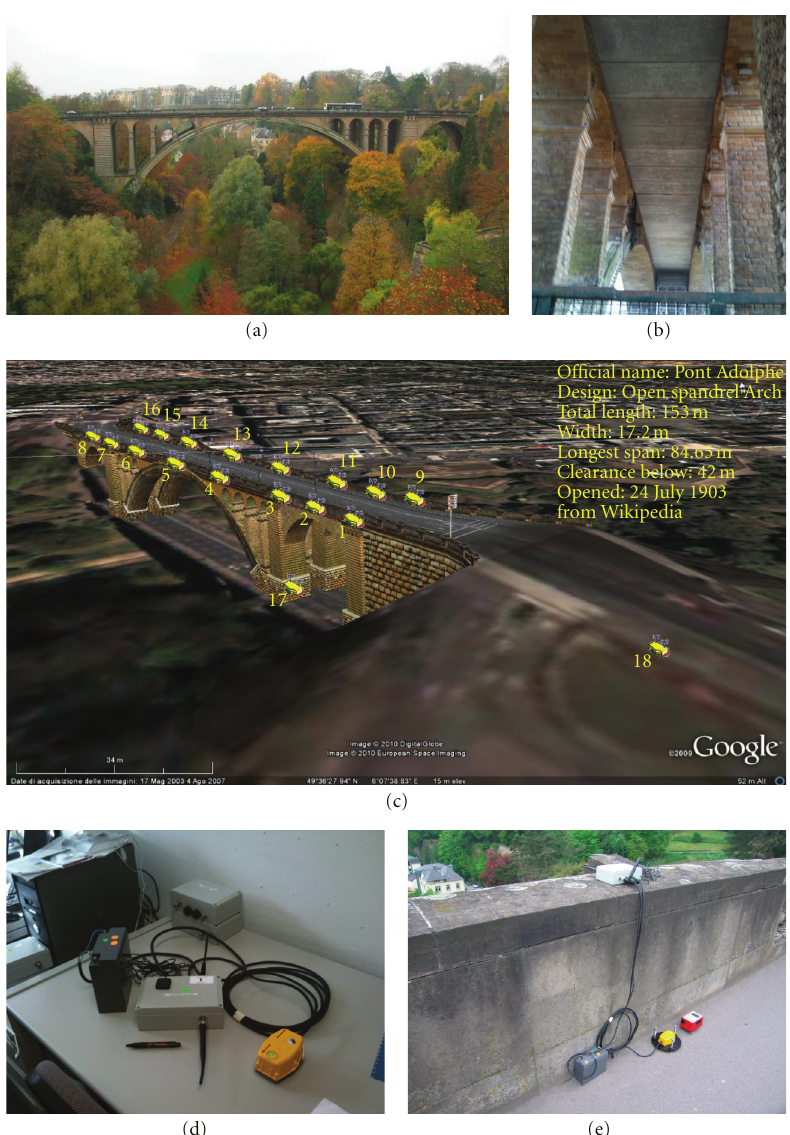
Figure 1: Photos of the Adolphe Bridge and instruments used and information on the measurement setup. (a) Sideview of the Adolphe bridge (source: Wikimedia Commons). (b) View from below. (c) Measurement setup used on the Adolphe bridge. (d) Wireless sensing unit (WSU) used for the ambient vibration measurements on the Adolphe bridge. The central part of the unit, including the digitizing board, is contained in the box shown in the center of the picture, with antennas for wireless data transmission. The 4.5 Hz geophone is the yellow instrument shown on the right. On the left, the battery providing the necessary power supply is depicted. (e) Deployment of one WSU on the bridge walkways. The geophone (yellow) is centered in a horizontal position on the walkway, with the two horizontal components oriented in the longitudinal and transverse direction with respect to the bridge, respectively. The red object in the picture is a Tromino (cid:2) sensor deployed by the Geological Survey of Luxembourg for comparative